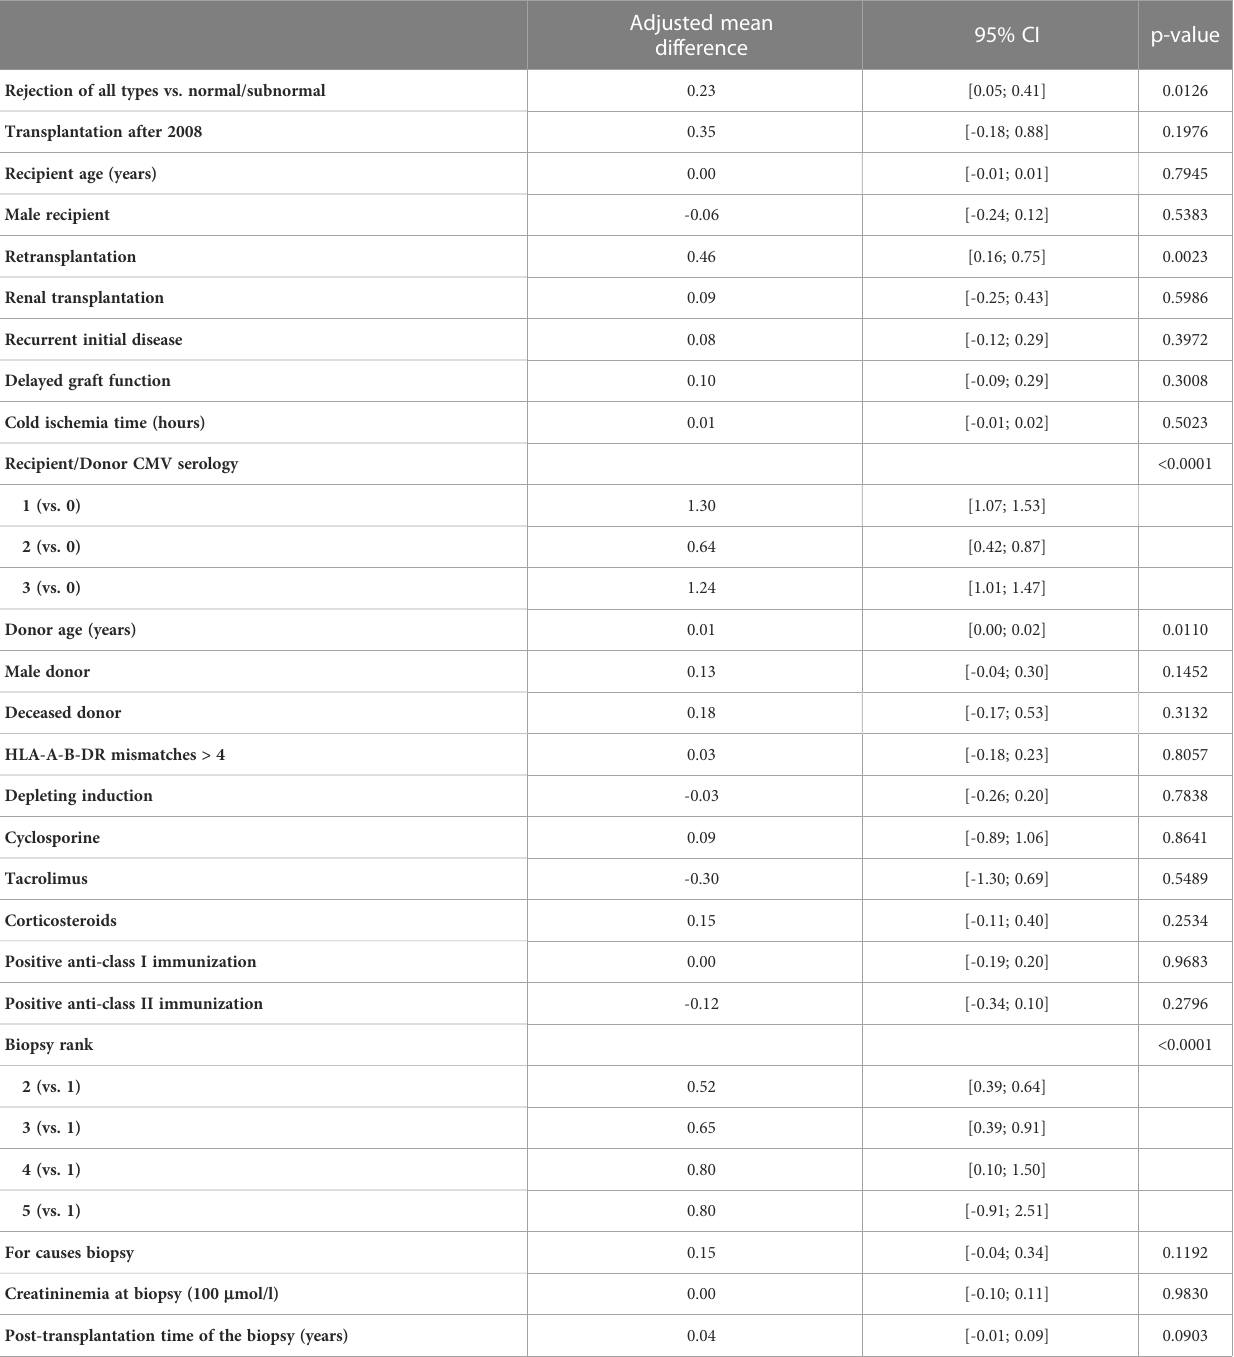
TABLE 7 Results of the multivariable linear mixed model of log of the ratio between CD28-CD8+ T cells in absolute number and Tregs in absolute number measured at the time of biopsy (Rejection of all types versus